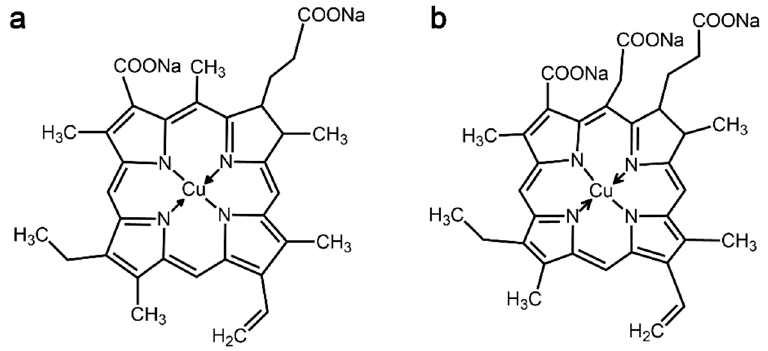
Figure 1. Two major components of SCC: ( a ) disodium copper chlorin e4 and ( b ) trisodium copper chlorin e6.